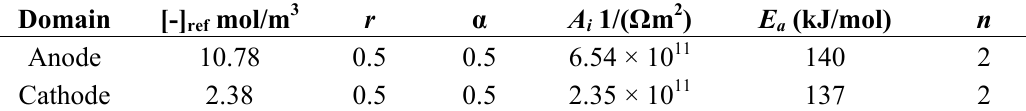
Table 3. Reference parameters for electrochemical reactions [15,16].